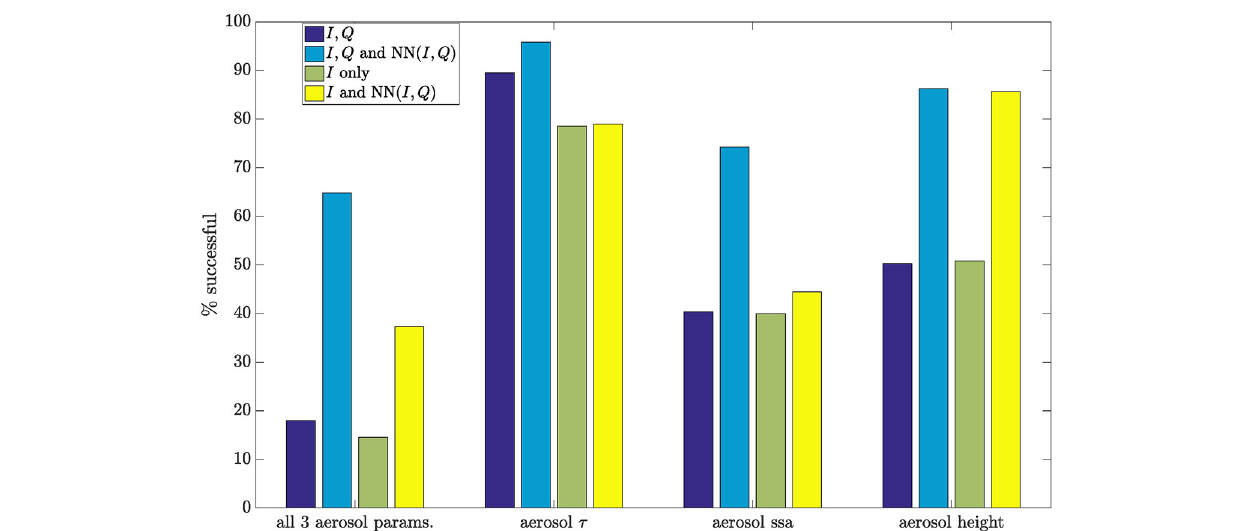
FIGURE 8 | The percentage of success for each of the four retrieval schemes is summarized for each retrieval parameter. Success is defined as being within ± 0.03 for the total aerosol optical depth at 869 nm, within ± 0.04 for single-scattering albedo (ssa) at 869 nm and either as correct or incorrect for the aerosol vertical location. The retrieval using I and Q with a NN-based first guess using I and Q is able to retrieve all 3 of these parameters 65% of the time, whereas the total radiance-only retrieval can only achieve this accuracy in about 37% of cases. As seen in Figures 6 , 7 , the total optical depth is generally retrievable if only the total radiance is available (79% successful), although that is improved to 96% successful for I and Q with the NN-based first guess. However, the retrieval of the single-scattering albedo is significantly improved with polarization information: 74% of cases are retrieved within ± 0.03 with I and Q and the NN-based first guess, compared to 45% using total radiance-only and the same first